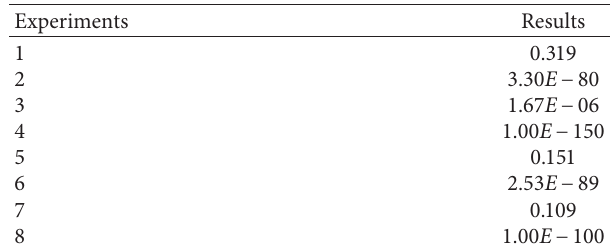
Table 8. Absolute delta values between minimum and